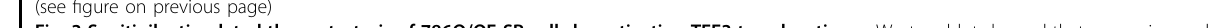
Fig. 3 Sunitinib stimulated the metastasis of 786O/OE-SR cells by activating TFE3 translocation. a Western blot showed that expression and distribution of TFE3 was dynamic between the nucleus and the cytoplasm. GAPDH and Histone served as speci fi c internal reference markers for cytoplasm and nuclei respectively. b The target genes of TFE3 were veri fi ed in786O/OE-SR cells treated with DMSO or sunitinib (10 μ M) for 12 h. Data are shown as means ± SD. * P < 0.05, ** P < 0.01, *** P < 0.001, NS: not signi fi cant. Data were obtained from three independent experiments. c After knocking down of TFE3, qPCR veri fi ed the target gene of TFE3 in 786 O/OE-SR cells treated with DMSO, sunitinib (10 μ M) for 12 h. ** P < 0.01, *** P < 0.001. Data are shown as means ± SD ( n = 3). d Proteins downstream of TFE3 in 786 O/OE-SR cell line were upregulated with the increase in sunitinib concentration. e After knocking down of TFE3, 786 O/OE-SR were treated with sunitinib (10 μ M) for 12 h cells and proteins downstream of TFE3 were down regulated. f Transwell assay to assess migration after 12 h incubation of 786 O/OE-SR with different concentration of sunitinib compared with 786 O/OE cells. Scale bar, 200 μ m, *** P < 0.001, ** P < 0.01, * P < 0.05, NS: not signi fi cant. Data are shown as means ± SD ( n = 3). g Transwell assay to assess invasion after 12 h incubation of 786 O/OE-SR with different concentration of sunitinib compared with 786 O/OE cells. Scale bar, 200 μ m. ** P < 0.01, *** P < 0.001. Data are shown as means ± SD ( n = 3). h Wound healing assays for 786 O/OE and 786 O/OE-SR cells with DMSO, sunitinib (10 μ M) for 24 h. Scale bar, 250 μ m. * P < 0.05, ** P < 0.01, NS: not signi fi cant. Data are shown as means ± SD ( n = 3). i Rescue experiments showed that knockout of TFE3 could reverse the effect of sunitinib on tumor metastasis in 786 O/OE-SR cells. Scale bar, 200 μ m, * P < 0.05, ** P < 0.01, NS: not signi fi cant. Data are shown as means ± SD ( n =